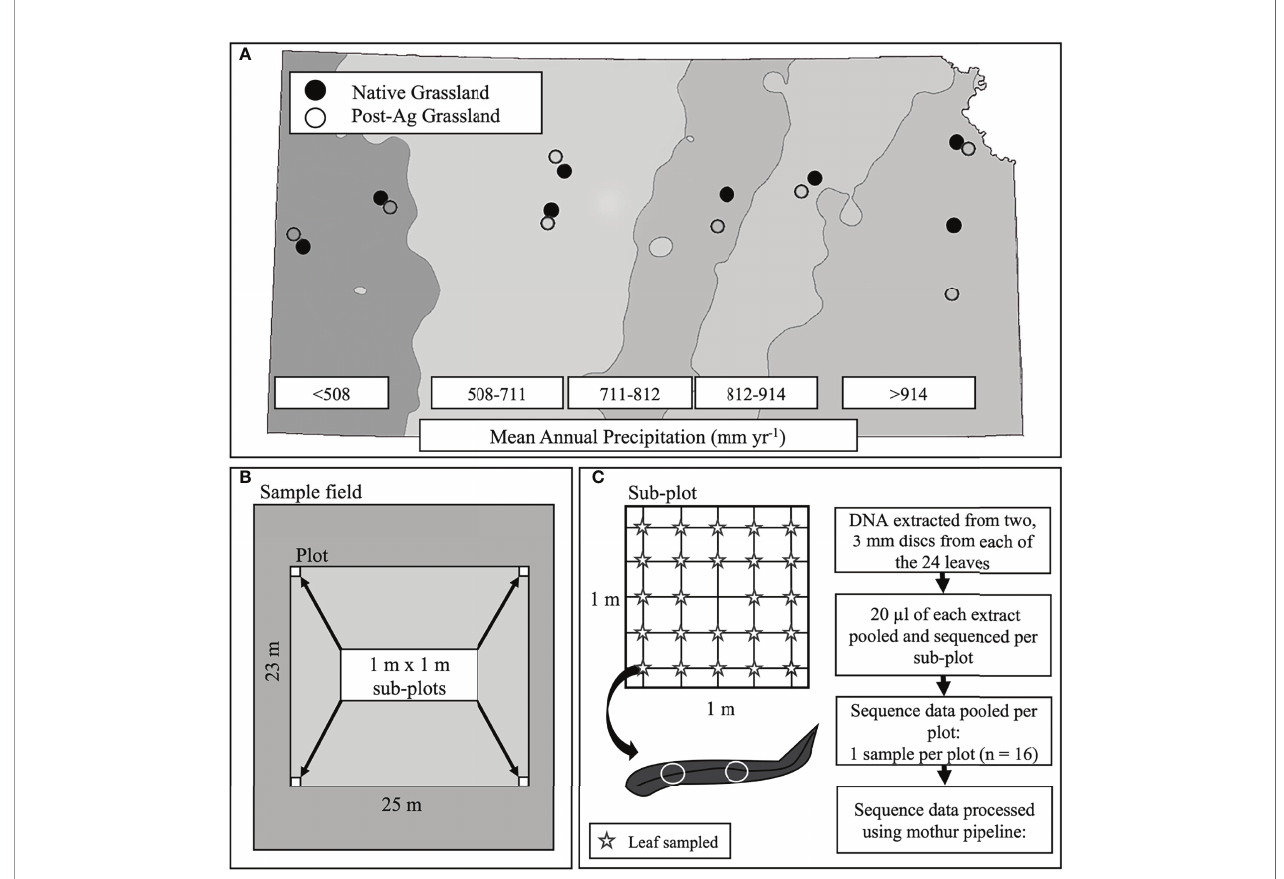
FIGURE 1 | A schematic of the experimental design including site locations across the precipitation gradient of Kansas, USA with mean annual precipitation (MAP) bands indicated with shading. Points indicate sampled sites (open circles – post-agricultural sites; solid circles – native prairie remnants) (A) , plot and sub-plot layout within each site (B) , and leaf sampling within each sub-plot and subsequent sample and sequence data processing (C)